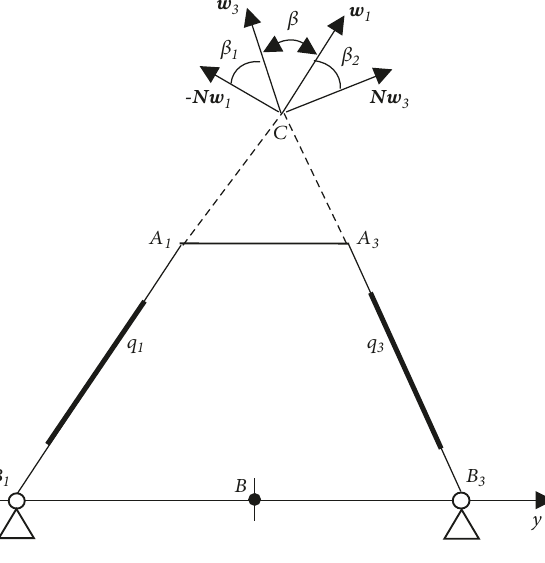
Right for the SPS limb, the acute angle 𝛽 𝑖 shown in Figure 12 is angle between the force ( w 1 ( w 3 )) generated at the same point of the two SPS limbs and the velocity ( Nw 1 ( − Nw 3 )) of point 𝐶 . It indicates that when the actu- ated joint is locked, there is transmission capability of the force/motion from limb 1 (3) to limb 3 (1) . 𝛽 is the angle between the w 1 and w 3